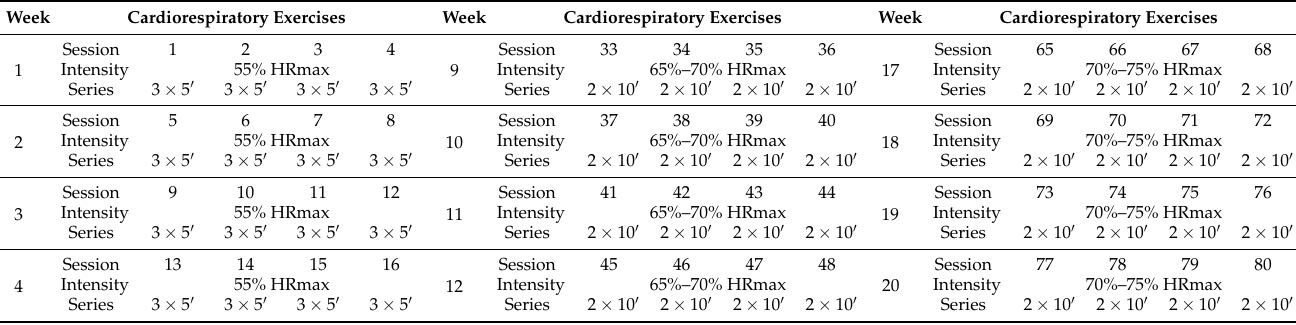
Table A4. Cardiorespiratory